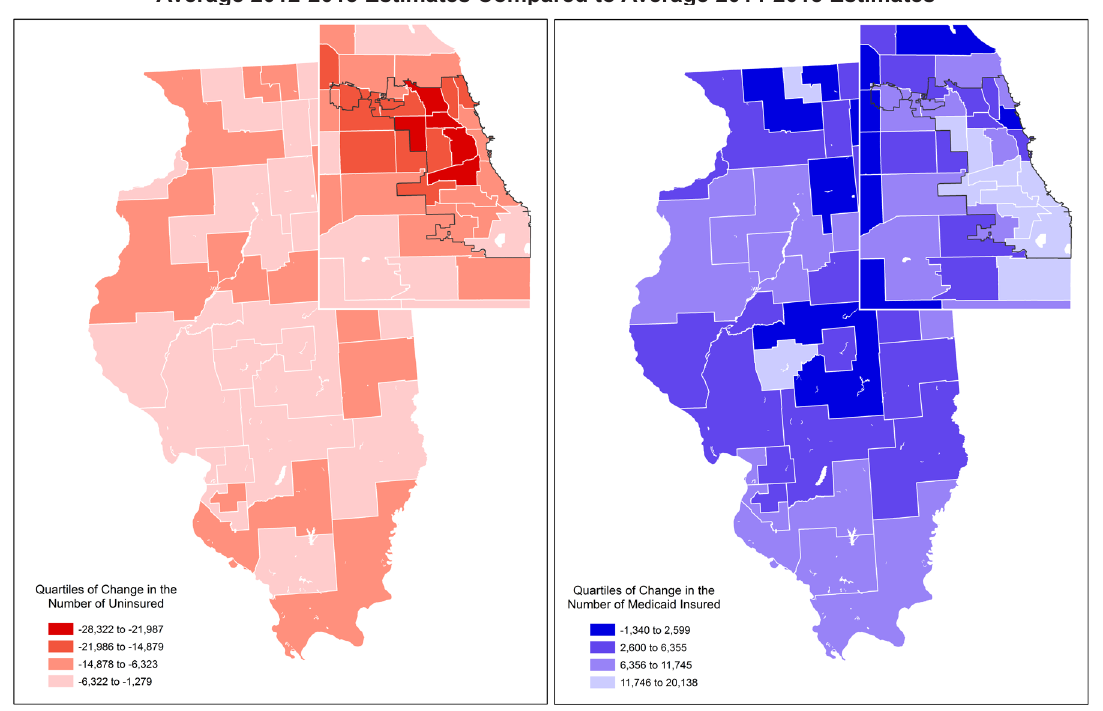
Figure 1. Quartiles of change in annual American community survey estimates of residents age 18-64 (A) uninsured, or (B) with Medicaid coverage for 88 Illinois public use micro